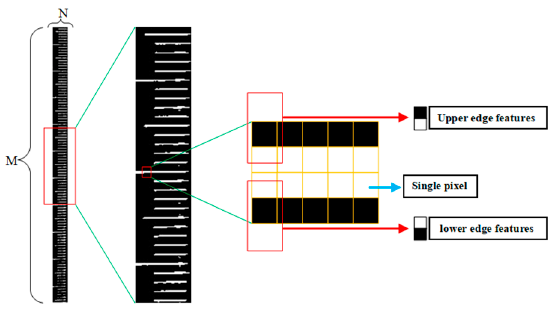
Figure 10. Upper and lower edge features in scale image.